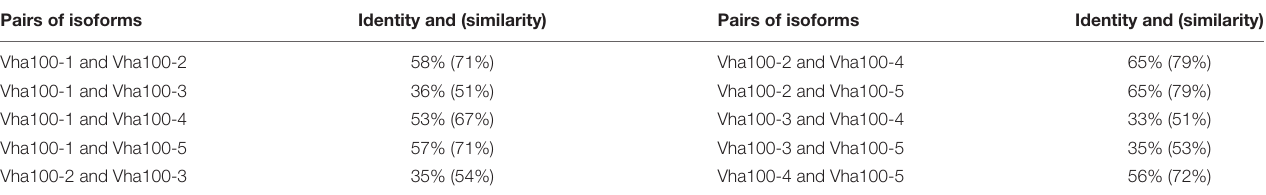
TABLE 1 | The sequence identity (and similarity) between pairs of Drosophila a subunit isoforms. Pairs of isoforms Identity and (similarity) Pairs of isoforms Identity and (similarity)